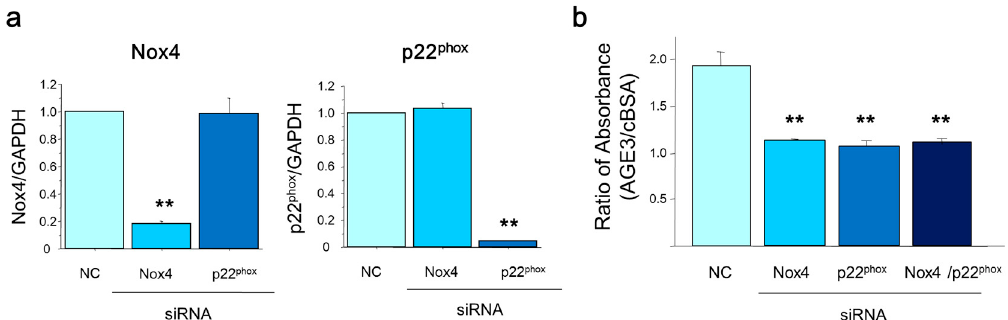
Figure 6. AGE3-BSA-induced apoptosis is mediated through Nox4 or p22 phox . ( a ) Nox4 or p22 phox siRNA was transfected to A7r5 cells, total RNA was isolated three days after transfection, and Nox4 and p22 phox mRNA levels were measured by real-time PCR, as described in the Method section. GAPDH mRNA was used as loading control. A scramble siRNA was used as a negative control (NC); ( b ) AGE3-BSA-induced apoptosis was inhibited by silencing of Nox4 and p22 phox mRNA. Apoptosis was evaluated by cell death detection ELISA kit. The absorbance in cells treated with AGE3-BSA was compared with that in cells treated with cBSA. The ratio was demonstrated after correction with each cBSA. Results were analyzed by one-way ANOVA and LDS post-hoc test. ** p < 0.001 vs. NC.